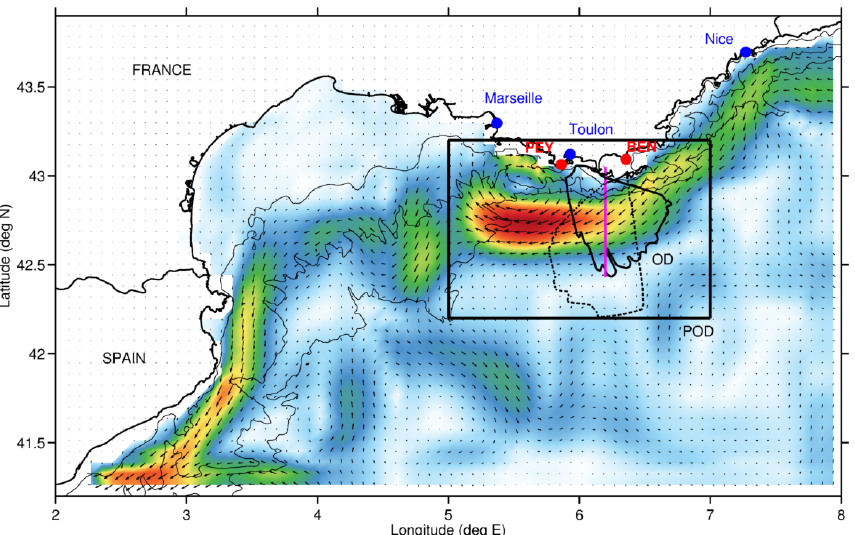
Figure 1. Depiction of the studied area. The larger area is the model domain (MD). Red points mark radar stations PEY and BEN. The black contour lines show areas where HF radar data are available more than 20% over the assimilation period for PEY (full) and BEN (dashed) radars and is called the observation domain (OD). The black box sketches the pseudo-observation domain (POD). The meridional magenta line crossing the coastal current will be used for Hovmöller diagrams. Surface currents of free simulation averaged over the assimilation period are shown. Color bars range from 0 (white) to 0.5 (red) ms − 1 . The 100, 1000 and 2000m isobaths are drawn (black thin